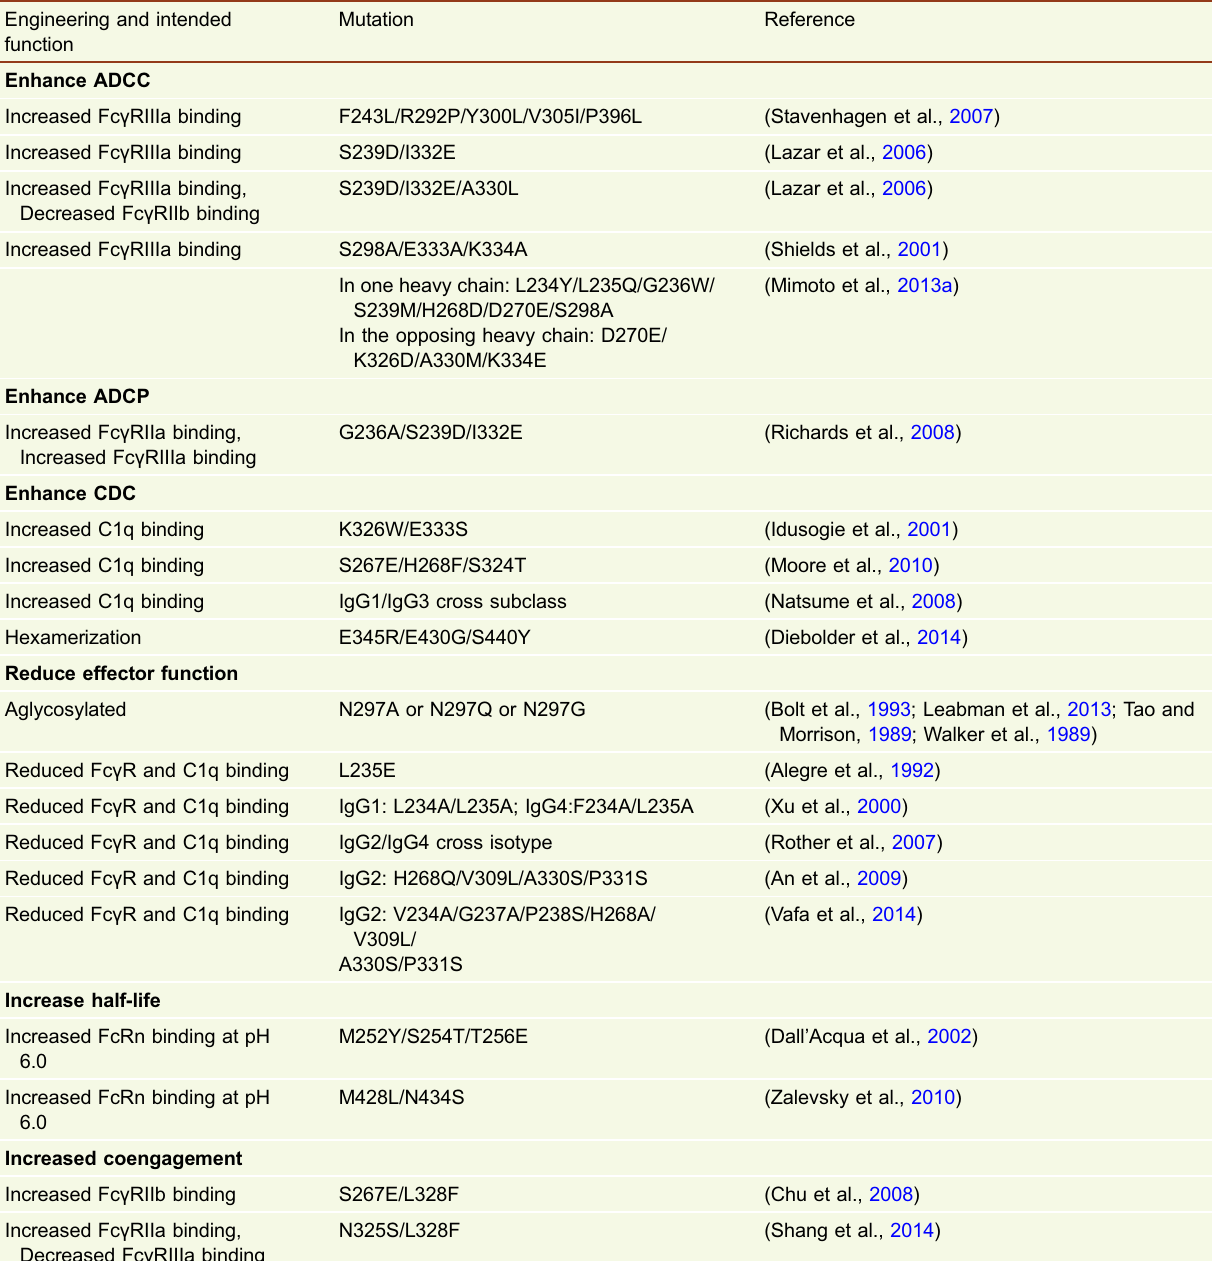
Table 1. Examples of modi fi cations to modulate antibody effector function. Unless otherwise noted, the mutations are on the IgG1 subclass